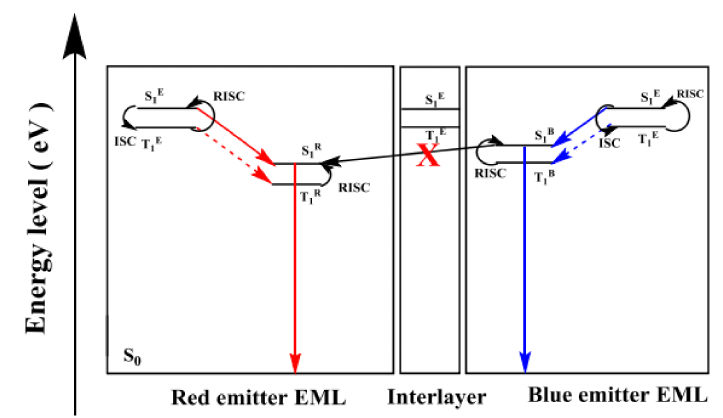
Figure 3. The exciplex host exciton energy diagram and possible decay ways of singlet and triplet excitons. (Solid arrow represents Förster energy transfer, dash arrow represents Dexter energy transfer and blocking mark represents singlet excitons energy stopping transfer). Reproduced with permission from [123], Elsevier,